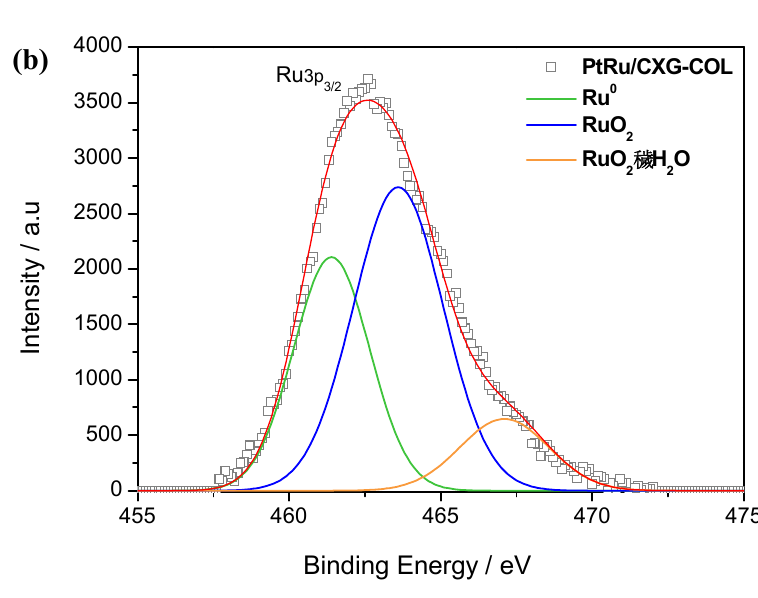
and Ru 3p signals for catalysts prepared, 7/2 3/2